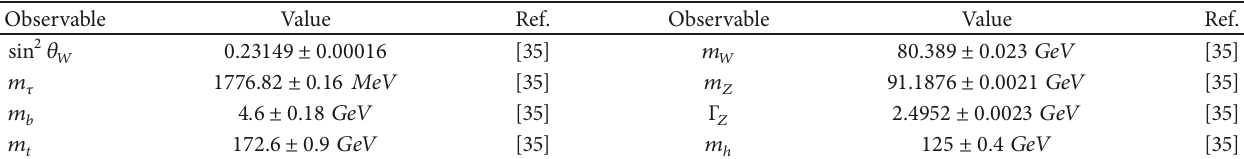
Table 1: Current experimental data.